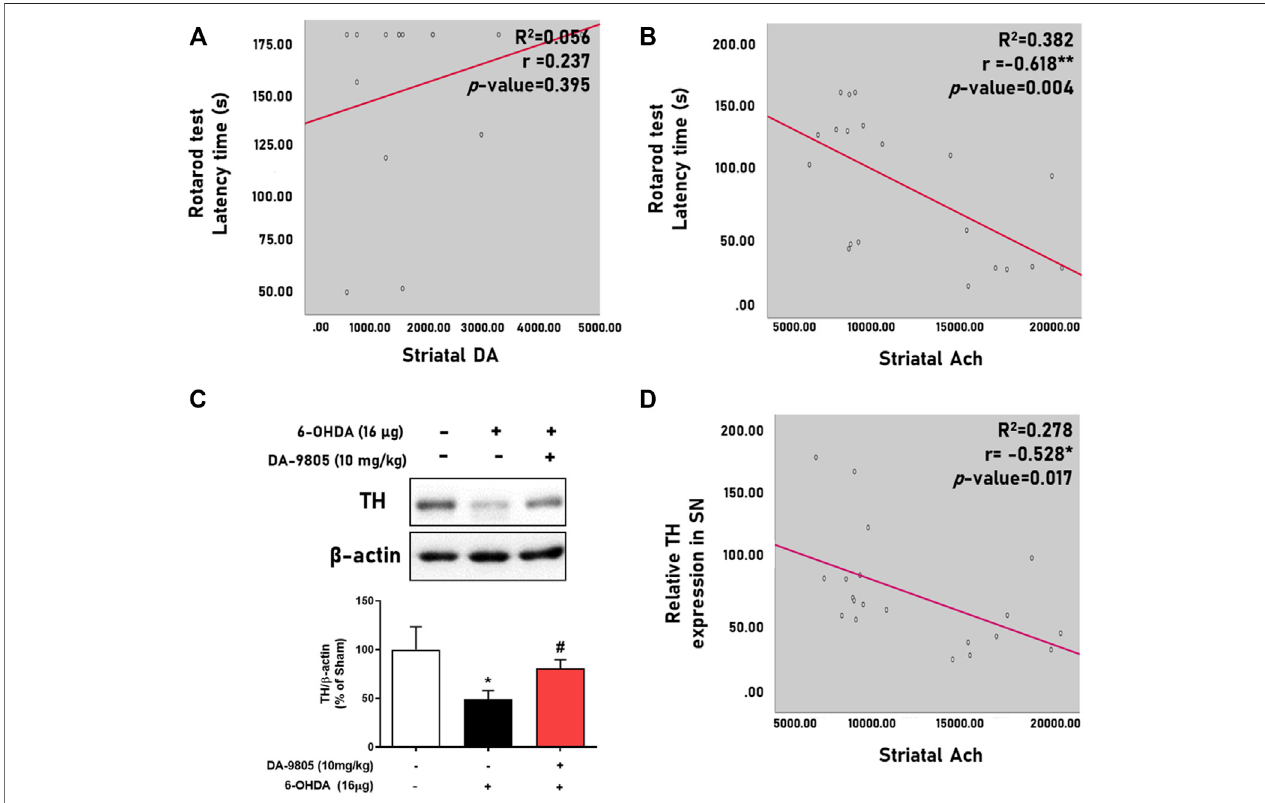
FIGURE 4 | Correlation between levels of striatal neurotransmitters and phenotypes of Parkinson ’ s disease. Linear regression graph of latency time in rotarod test and striatal dopamine (DA) or acetylcholine (Ach) (A,B) , representative band image of tyrosine hydroxylase (TH) expression in the substantia nigra (SN) and their intensitieswereshownbythegraph (C) .LinearregressionoftherelativeTHexpressioninSNandstriatalAch (D) .N=4pergroupfor Figure4A andN=4inShamgroup and N = 8 in 6-OHDA and DA-9805 groups for Figures 4B – D .